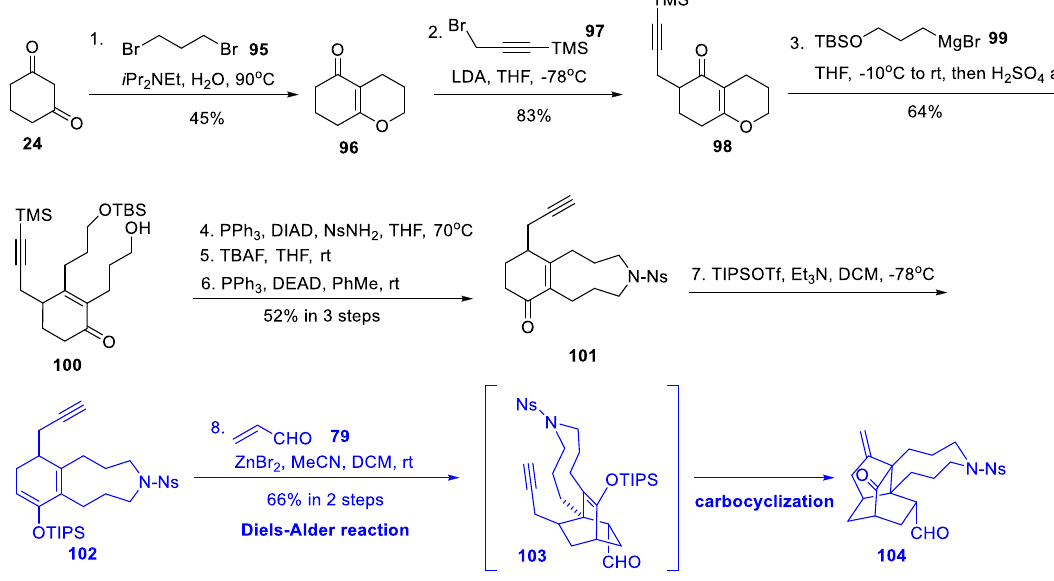
Scheme 10. Synthesis of the azonane-ring-embedded isotwistane cage (He,